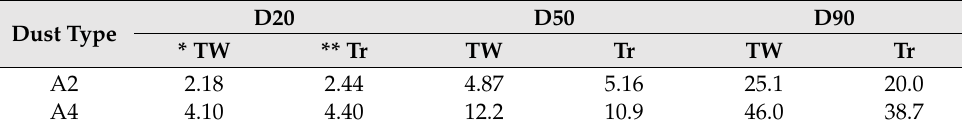
Table 5. Statistical analysis by dust particle size of Test water and Treated water (statistical significance